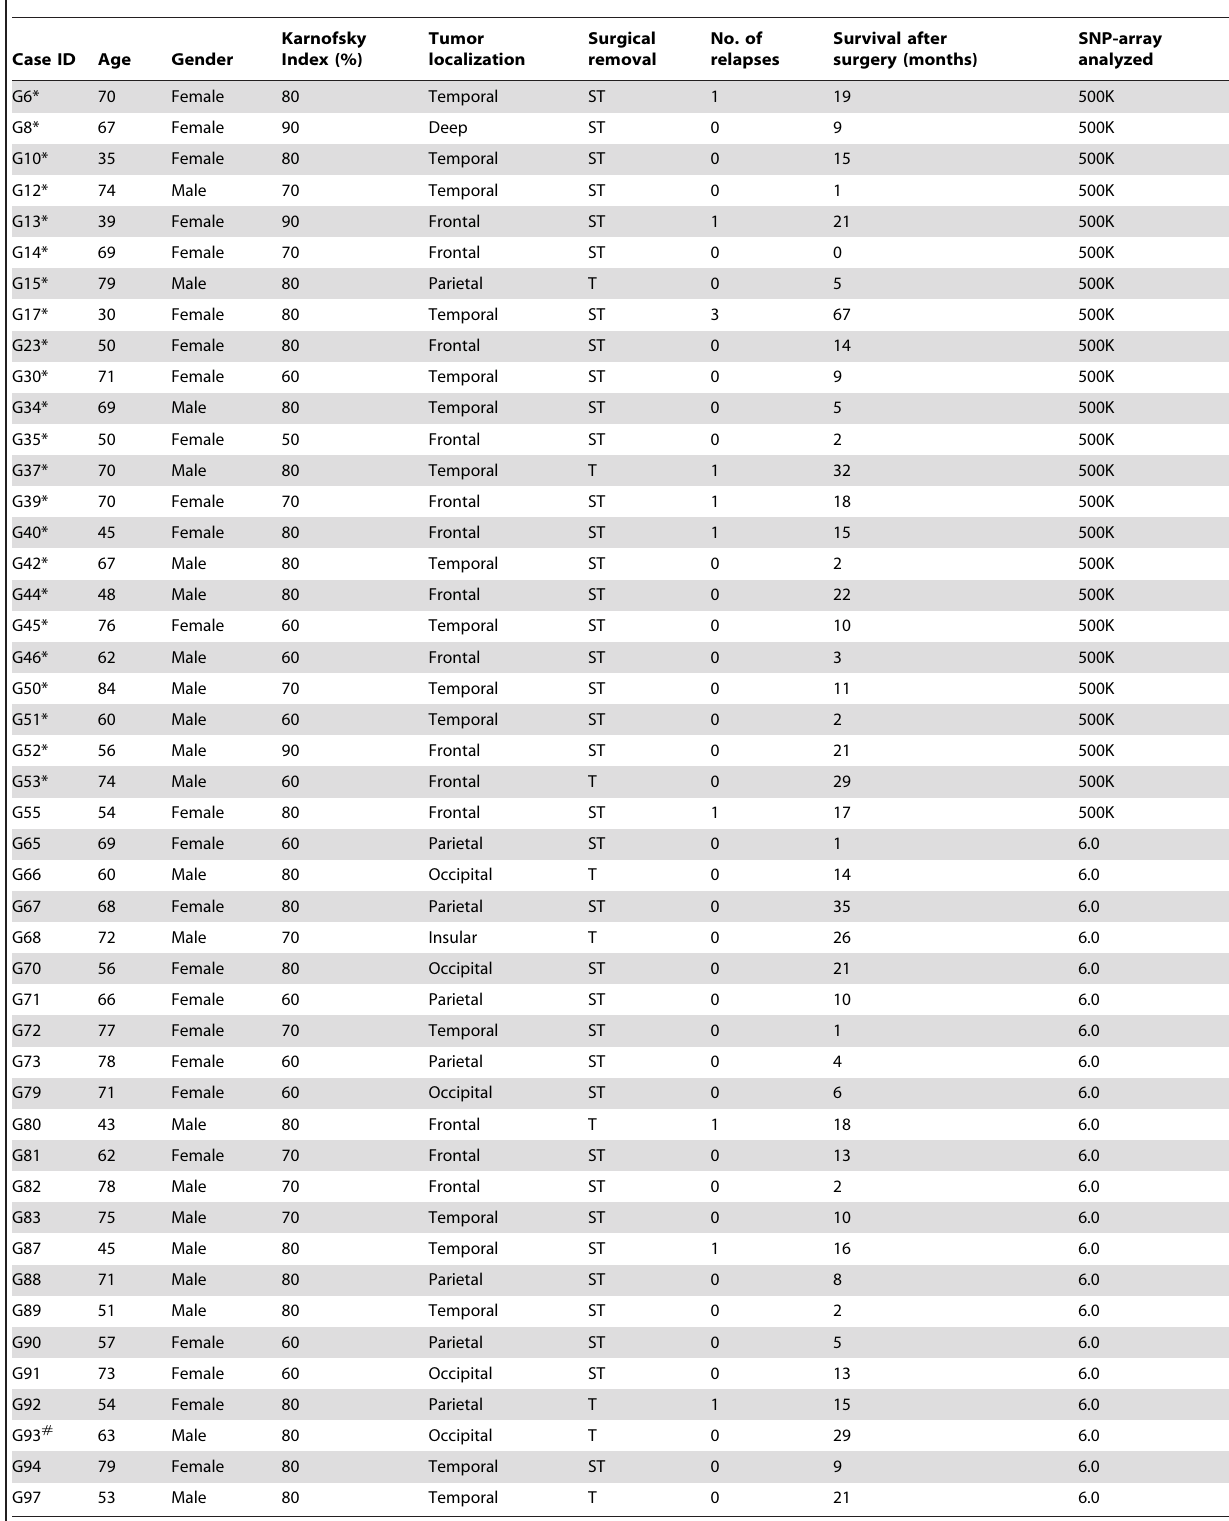
Table 1. Clinical characteristics of GBM patients (n =46) included in this study with information about the type of SNP-arrays used in each case to investigate DNA CN